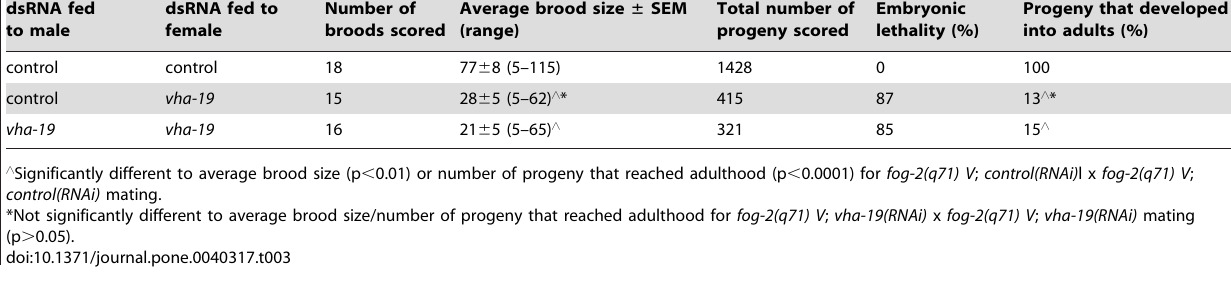
Figure 2. vha-19(RNAi) adults produce fewer oocytes beyond 24 hours of exposure to vha-19 dsRNA. A) The average number of eggs laid every 24 hours by control(RNAi) or vha-19(RNAi) adults feeding on dsRNA. Error bars represent the standard error of the mean (s.e.m). ***indicates p , 0.001. B) The average number of oocytes in the proximal oviduct of either wild type or AZ212 (pie-1::H2B::GFP) C. elegans fed on control or vha-19 dsRNA for 24 or 48 hours. C) The proximal oviduct of AZ212 C. elegans fed control or vha-19 dsRNA for 24 hours. White arrows indicate normal oocyte nuclei. Endomitotic oocytes in the oviduct are indicated by a square bracket. Note that both oocytes with multiple nuclei (most proximal oocyte in square bracket), and oocytes in which the chromosomes have started to decondense prematurely (indicated by the green background of the two most distal oocytes in the square bracket), are endomitotic. The irregular, bright, particulate dots in the distal gonad (dg) are autofluorescent gut granules. Scale bars indicate 10 m m. D) The percentage of endomitotic oocytes observed in the oviducts of wild type or AZ212 C. elegans fed control or vha-19 dsRNA from the L4 stage for 24 or 48 hours.